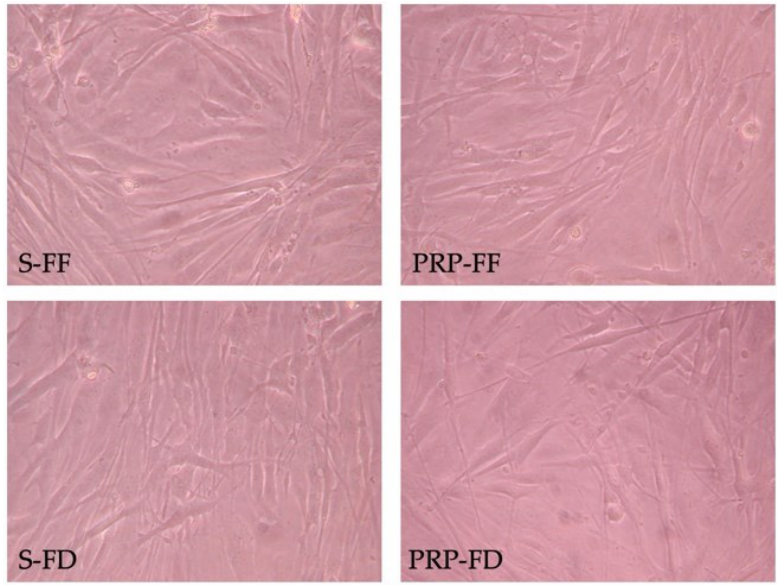
Figure 2. MIO-M1 cell culture. Representative images of MIO-M1 cells cultured in a DMEM culture medium supplemented with 5% Fresh Frozen serum (S-FF), Freeze-dried (S-FD) serum, Fresh Frozen Plasma-Rich Platelet (PRP-FF), or Freeze-dried PRP (PRP-FD). Scratch Wound Assay